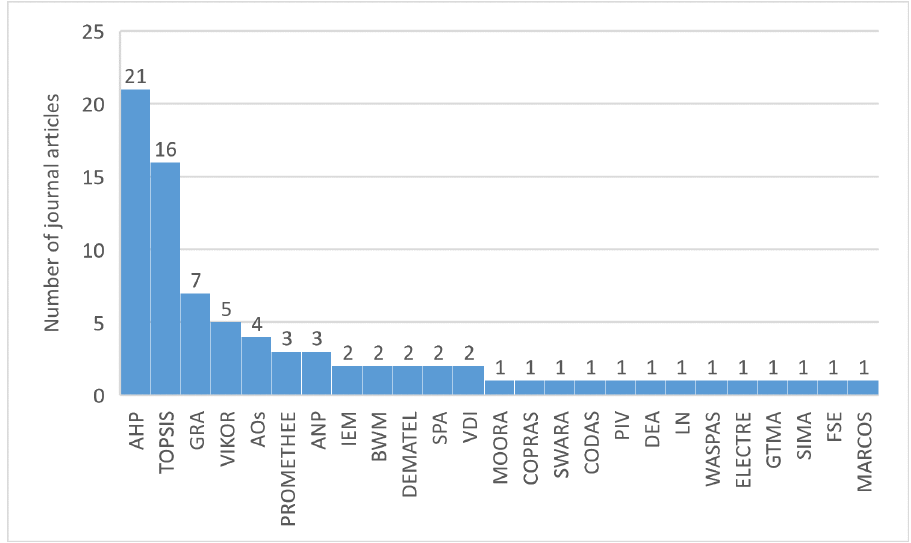
Figure 8. Distribution of the single methods integrated in the hybrid